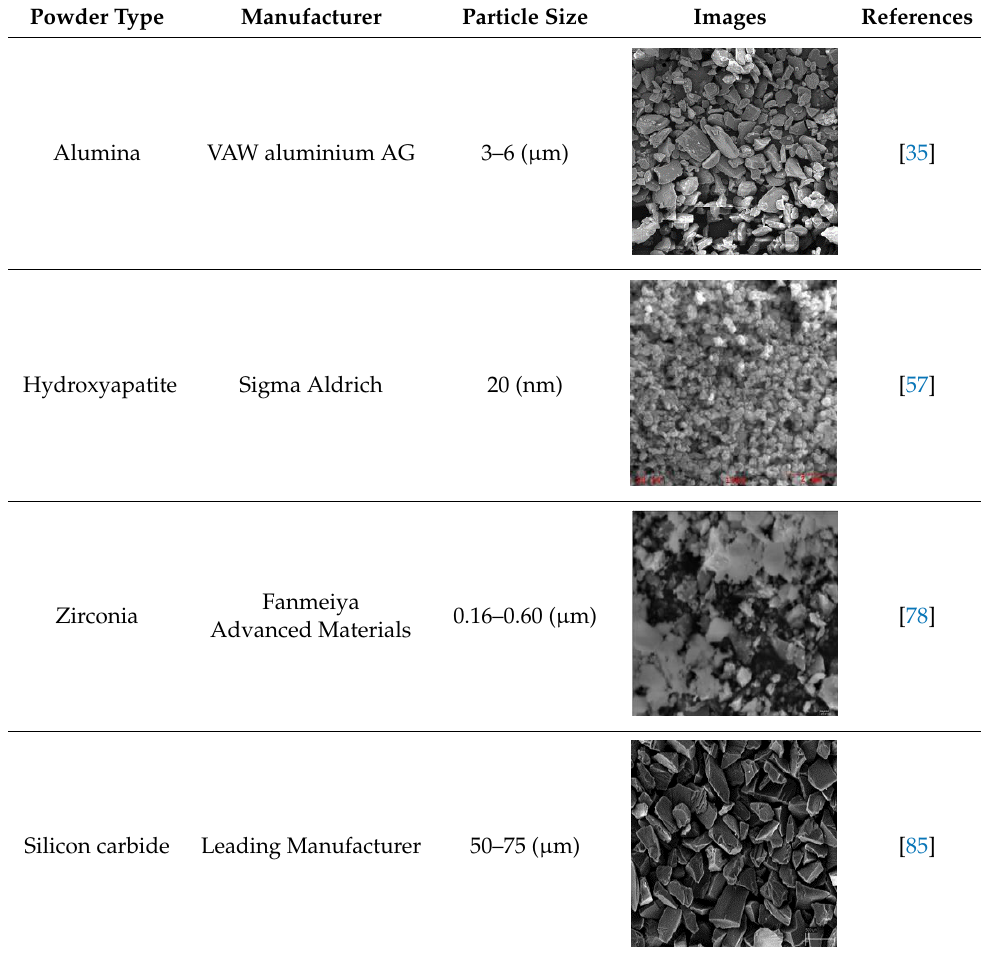
Table 5. Various ceramic powders and their morphologies.